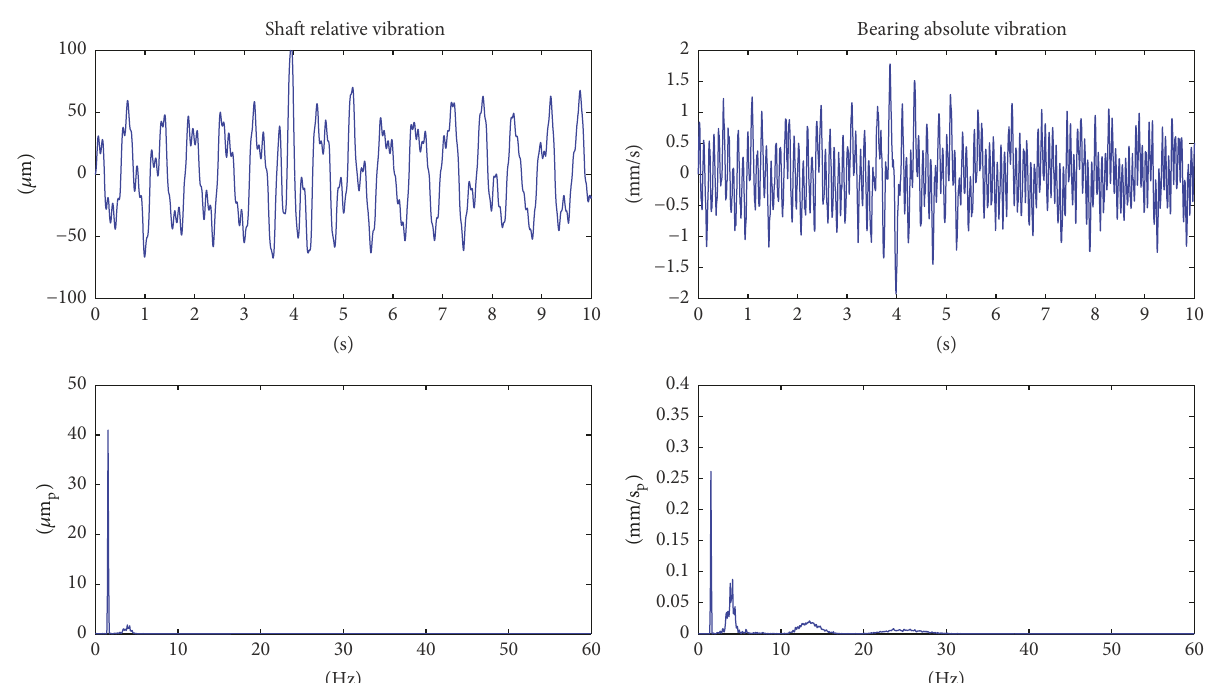
Figure 17: Simulated shaft relative and bearing absolute vibrations at 𝑋 direction of the upper journal bearing, when generator rotor had an unbalance G4.25.